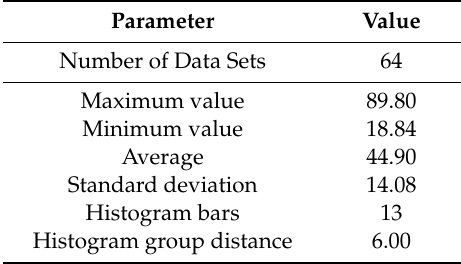
Table 2. The parameters for statistical analysis of λ